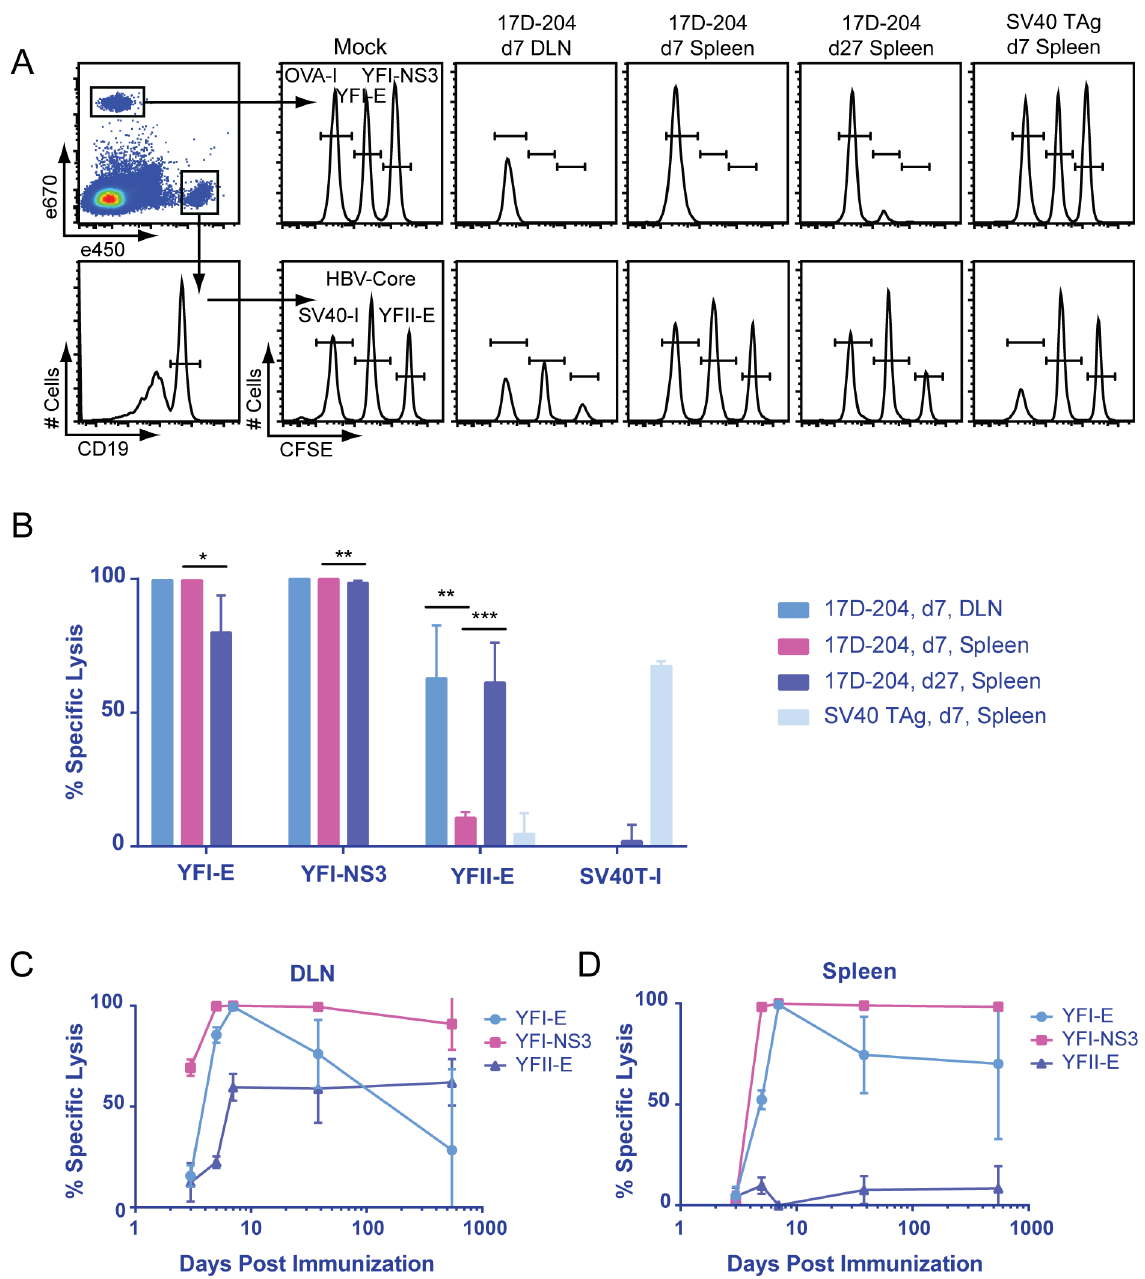
Fig 9. 17D-204-specific T cells are cytolytic. 5 – 6 week old mice were immunized s.c. with 17D-204 or intraperitoneally with cells immortalized by the SV40 virus. Splenocytes from a naive mouse were loaded with the indicated peptides, fluorescently labeled, mixed, and adoptively transferred into the immunized mice. At the indicated times post vaccination, in-vivo cytotoxicity directed against splenocytes loaded with the indicated peptides was evaluated by (A) the displayed flow cytometric gating strategy. (B-D) Specific lysis was calculated as described in the methods. Results are representative of two experiments (n = 3 – 5 for d3-d38 p.i. and n = 2 for d547). Data are displayed as mean ± SD for individual animals. *** , p < 0.001; ** , p < 0.01; * , p < 0.05 as determined by Student's